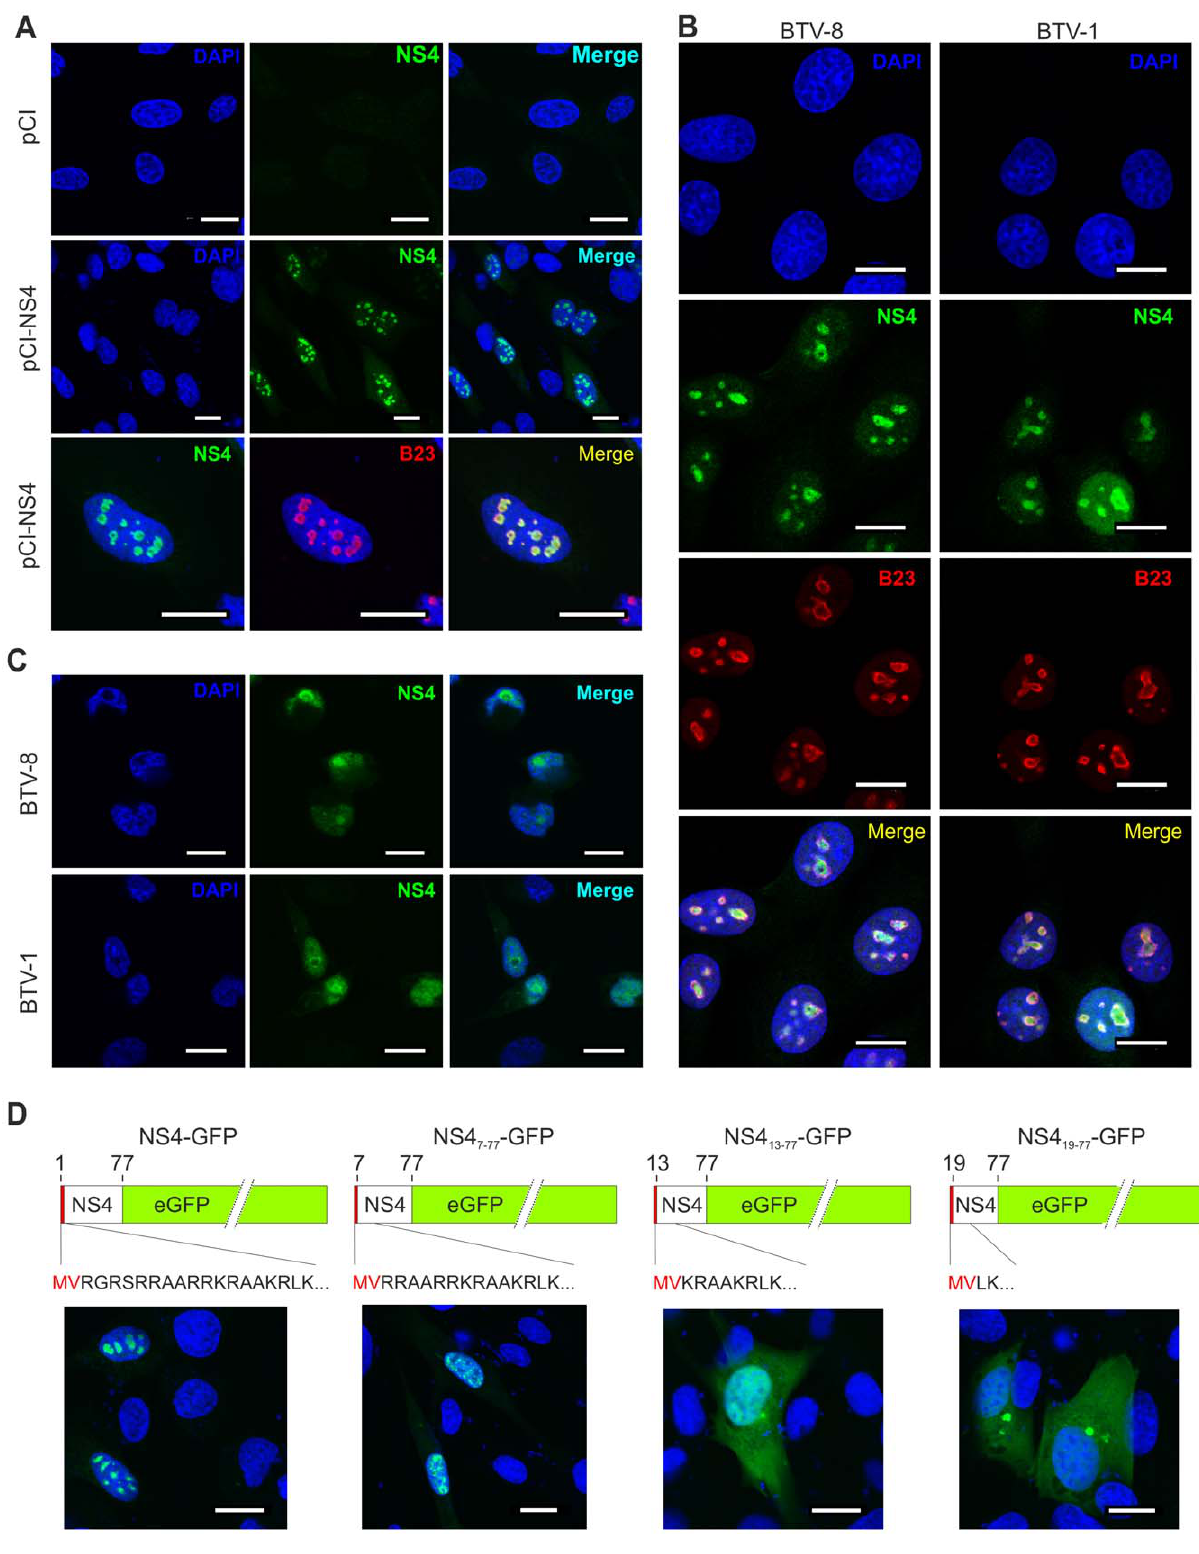
Figure 2. NS4 localises in the nucleoli of transfected and infected cells. (A) Confocal microscopy of CPT-Tert cells transfected with pCI-NS4 or empty pCI as a control. At 24 h post-transfection, cells were fixed and analyzed by immunofluorescence using antibodies against NS4 and as indicated the nucleolar marker B23 with the appropriate conjugated secondary antibodies as described in the Materials and Methods. Scale bars correspond to 18 m m. (B) Confocal microscopy of BSR cells infected by BTV-1 and BTV-8 at a MOI of 0.01. At 24 h post-infection, cells were fixed and analyzed by immunofluorescence as indicated in A. Scale bars correspond to 14 m m. (C) Confocal microscopy of C6/36 cells infected by BTV-1 and